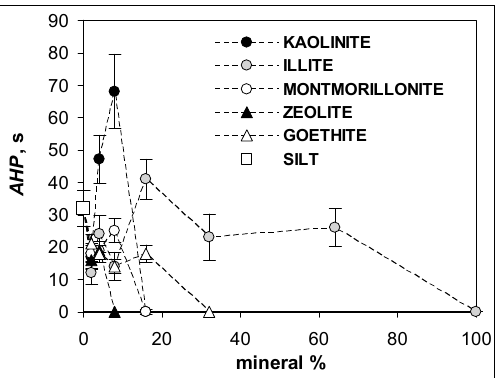
Figure 9. Dependence of the apparent hydrophobicity period on the added minerals’ percentage. Error bars are standard deviations.